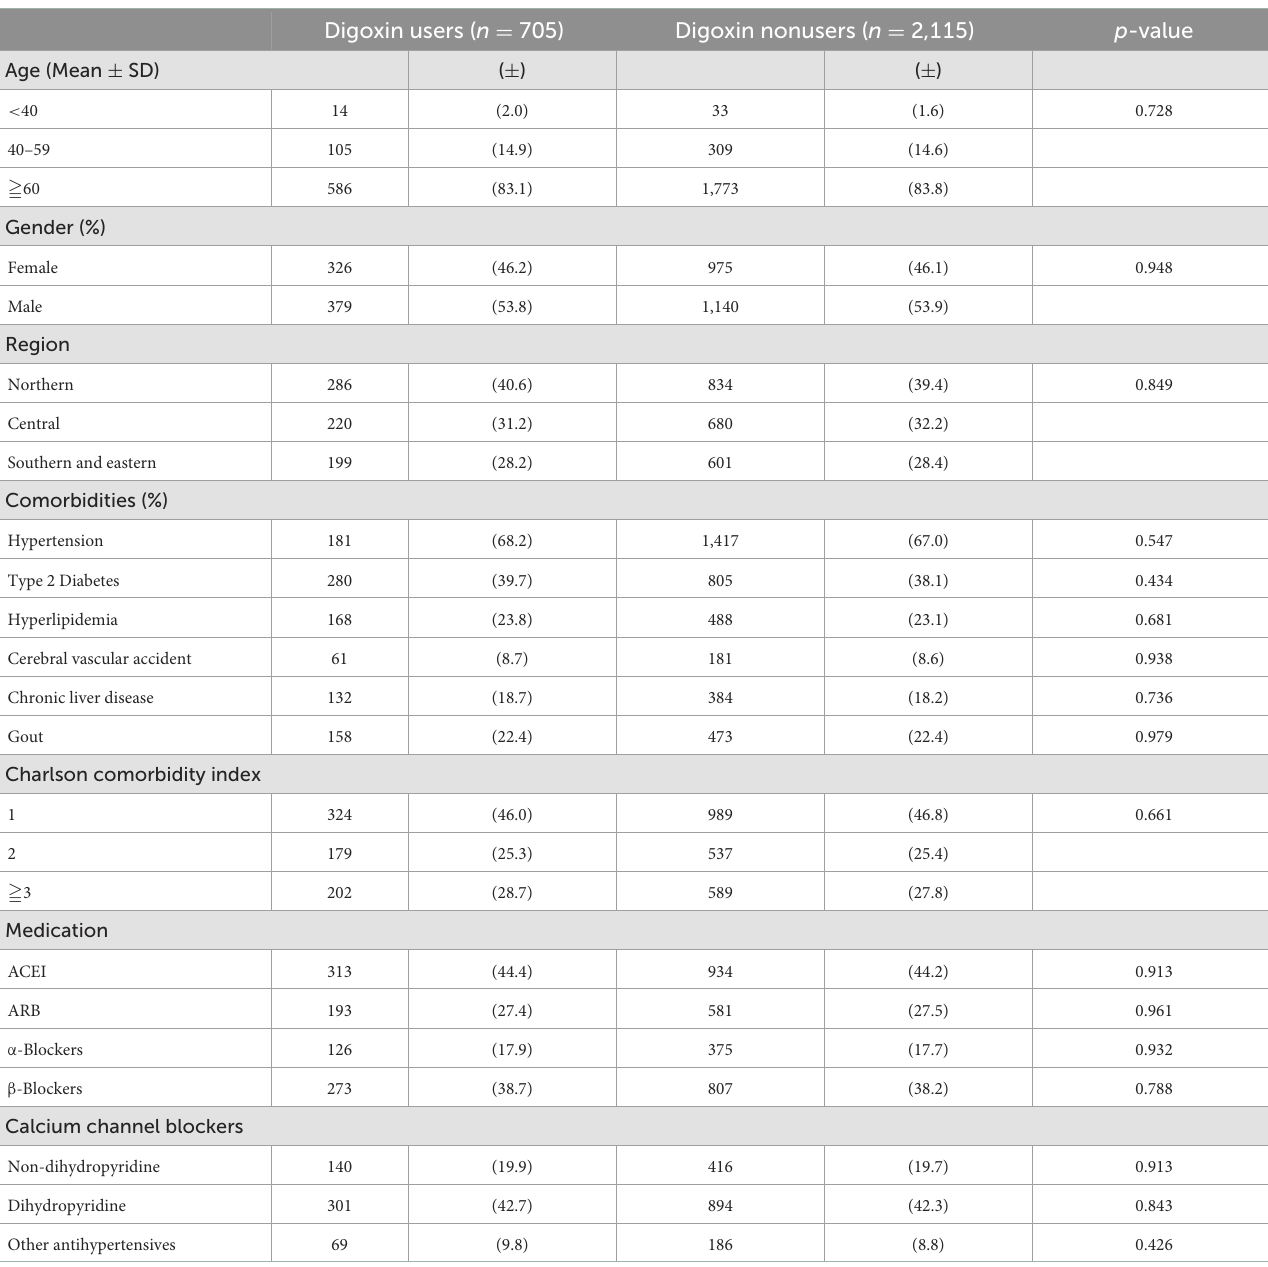
TABLE 1 Demographic characteristics between digoxin users and non-users in patients with